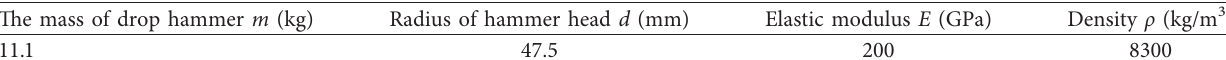
Figure 2: RC slab specimen. Table 1: Specific parameters of the